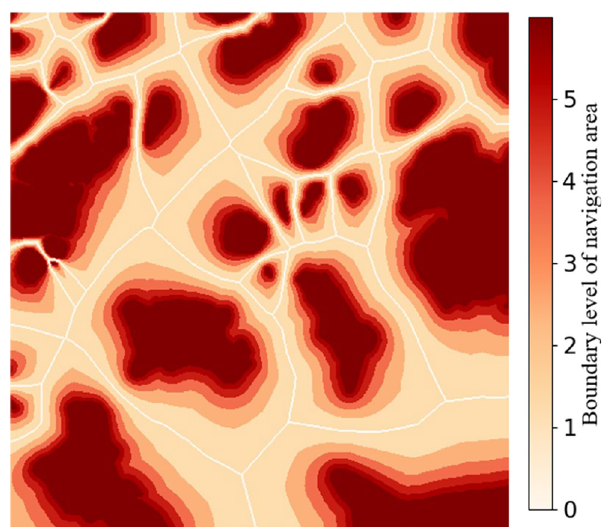
Figure 7 Navigation boundary level map